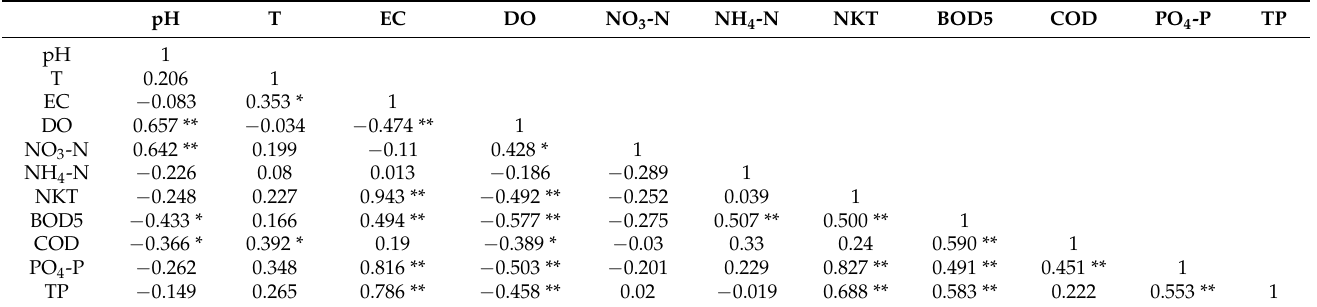
Table 5. Correlation matrix between studied